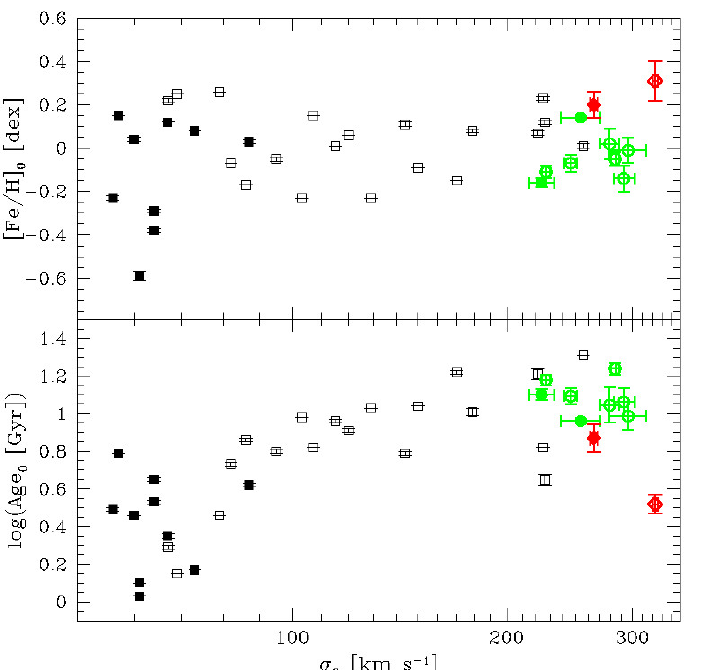
Figure 6. Central metallicity ( top panel ) and central age ( bottom panel ) as a function of the central velocity dispersion. Red diamonds are taken from Corsini et al. [97], green open circles from Eigenthaler and Zeilinger [94], green filled circles from Proctor et al. [95], open and filled squares are the early-type normal and dwarf galaxies with σ > 50 km s − 1 from Koleva et al. [101]. The original image can be found in Corsini et al. [97] (see their Figure